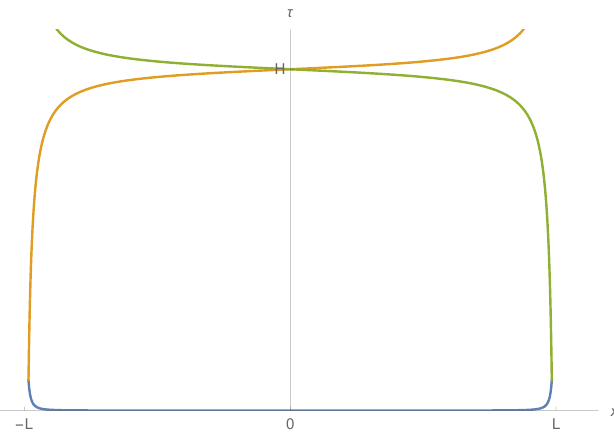
Figure 1 . The spacetime boundary of the optimized path integral for the SSD deformed back- ground on the interval x ∈ [ − L, L ] . If one treats the boundary conditions carefully, and solves for the boundary cosmological constant µ B , one finds that the spacelike portions of the boundary τ = F − ( x ) (orange) and τ = F + ( x ) (green) intersect with each other, yielding a finite domain of path